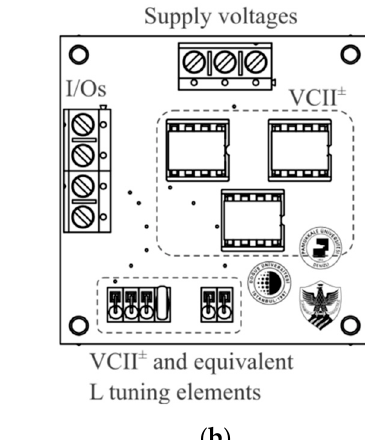
Figure 16. Implementation of the VCII ± by utilizing AD844s.